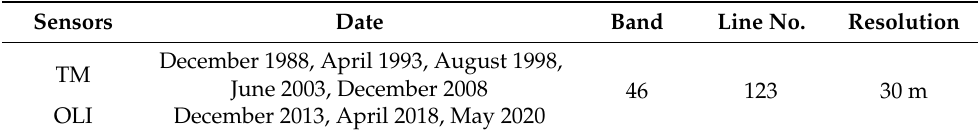
Figure 1. Study Area. Table 1. Mangrove RS imageries in Qinglan Bay.